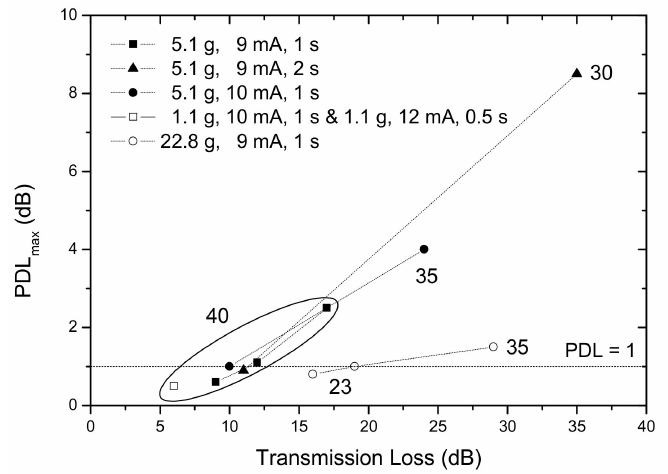
Figure 16. PDL values as a function of the transmission loss (LP 14 cladding mode resonance) of several gratings produced under different fabrication parameters in the SMF28 fiber. Reprinted with permission from ref. [81]. © 2021